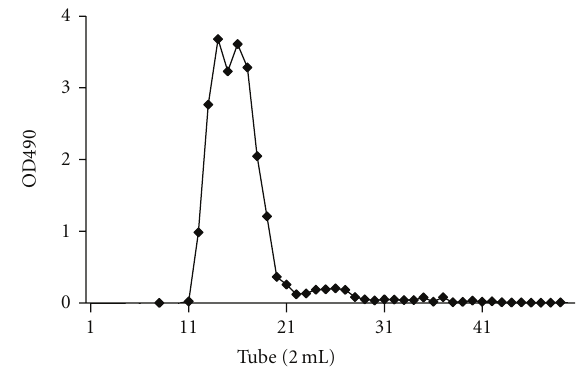
Figure 1: Size exclusion chromatography diagram of recycled β - 1,3-glucan from the waste residue of G. lucidum. Samples were isolated using a Sephadex G-15 column (HMG: 11–13; LMG: 14– 20; OSG: 23–29 tubes), and the sugar content of each tube was determined using phenol-sulfuric acid analysis (OD 490